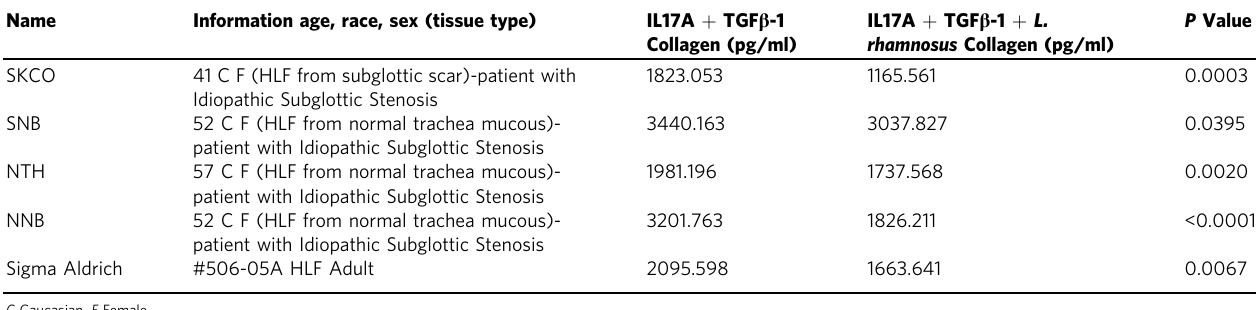
Table 2 Human Lung Fibroblast